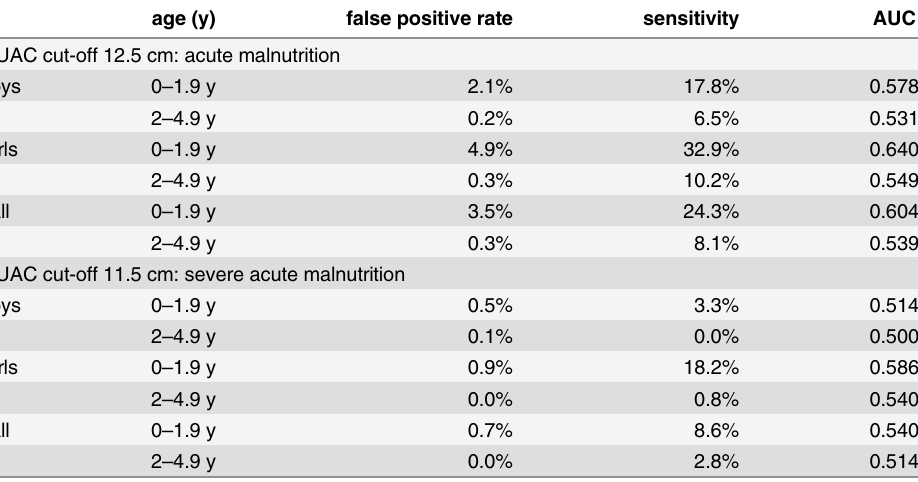
Table 2. Validity of actual WHO cut-off for severe and acute malnutrition in children < 5